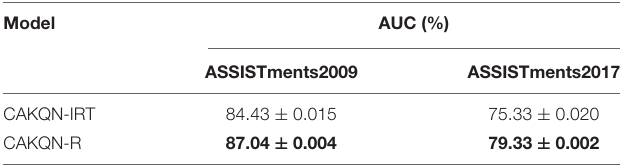
TABLE 5 | Experimental comparison between CAKQN and